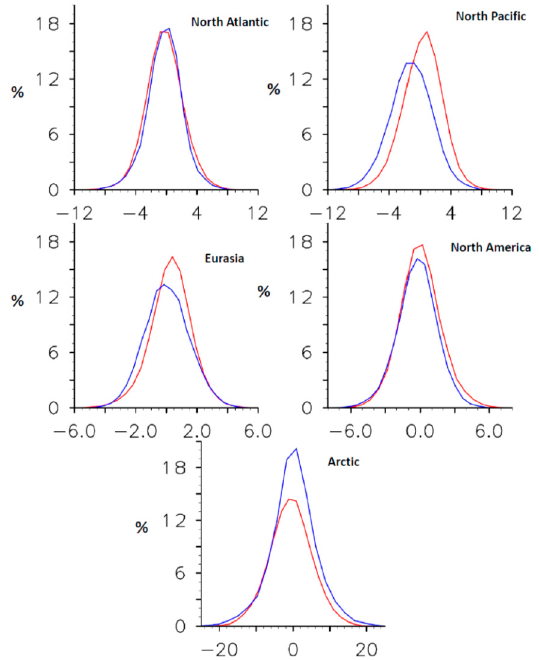
Figure 6. Probability Density Function (PDF) of CAI—cyclone activity index anomaly (along x -axis) for the sub-regions. Red lines for Pos (more sea ice years) and blue line for Neg (less sea ice years).